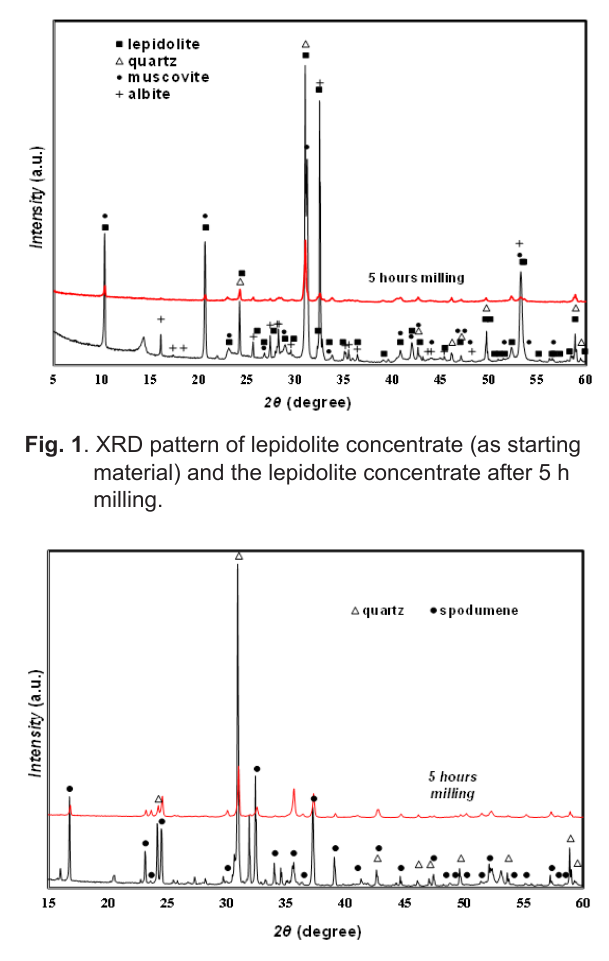
Fig. 2 . XRD pattern of spodumene concentrate (as starting material) and the spodumene concentrate after 5 h